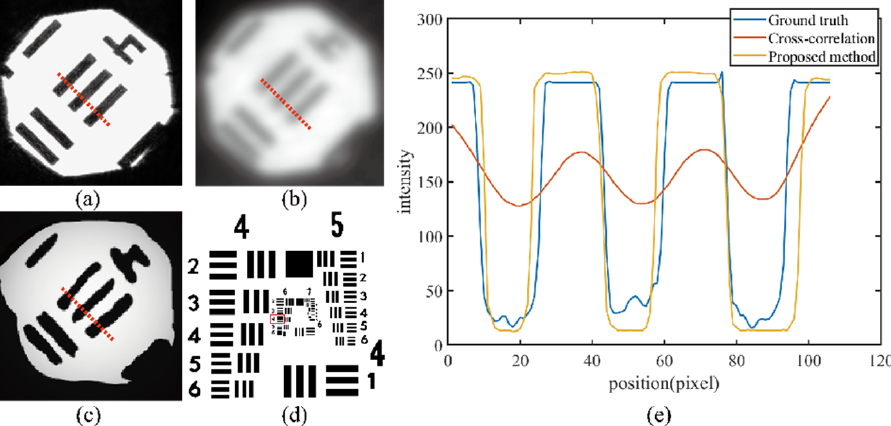
Figure 10. Experimental results of 1951 USAF target. ( a ) Ground truth; ( b ) Results of the cross- correlation algorithm; ( c ) Results of the proposed strategy; ( d ) Un-cropped object by the proposed strategy; ( e ) Profiles of the red dashed lines in ( a – c ).